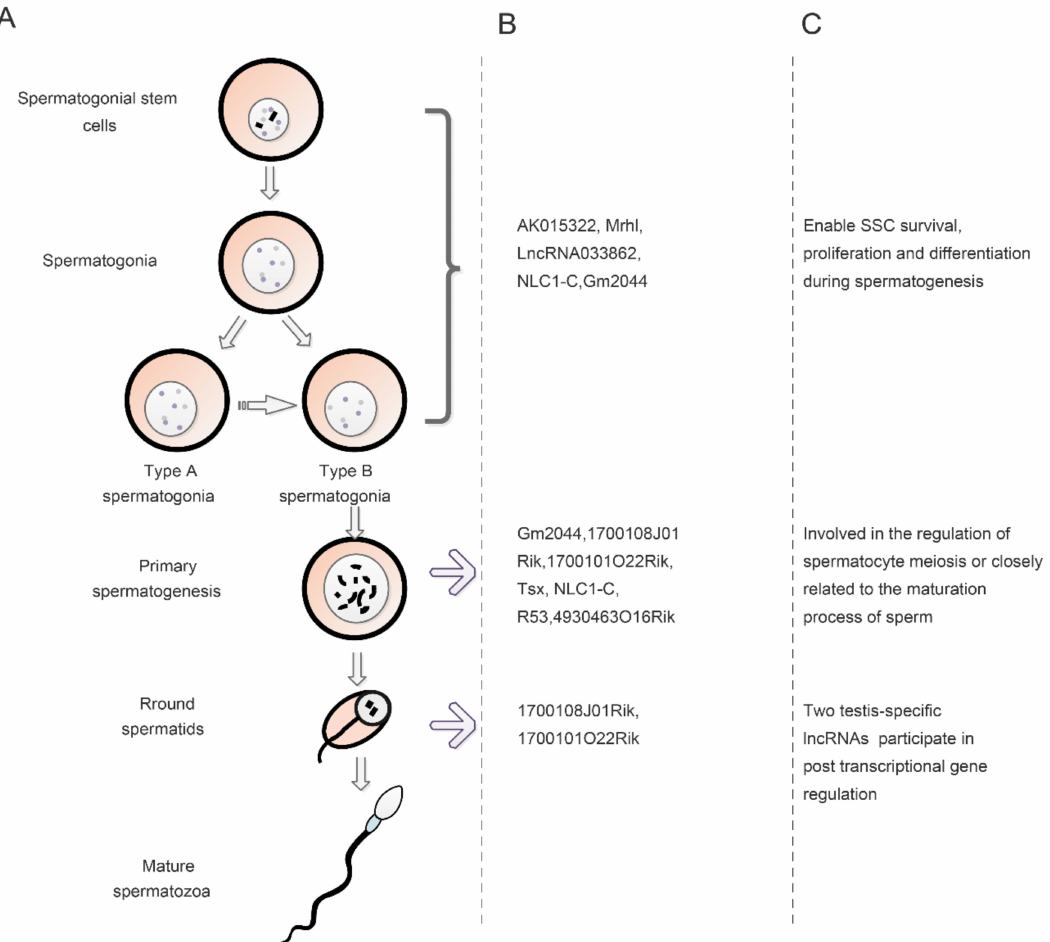
Figure 4. The different stages of spermatogenesis during which a spermatogonium undergoes division, differentiation, and meiosis to produce spermatozoa. ( A ) The process of spermatogenesis. ( B ) The lncRNAs that are involved in the regulation of spermatogenesis. ( C ) The primary function of lncRNAs in the regulation of spermatogenesis. Gonocytes produce spermatogonial stem cells in the postnatal testes; these develop from the primordial germ cells. Spermatogonial stem cells then undergo mitosis to produce type A spermatogonia, thus producing spermatogonial stem cells. These then develop into type B spermatogonia, which differentiate germ cells into diploid primary spermatocytes. During meiosis I, primary spermatocytes divide into secondary spermatocytes. During meiosis II, the secondary spermatocytes produce four haploid spermatids. During spermiogenesis, spermatids differentiate to produce spermatozoa through morphological changes, including flagellum development, nuclear condensation, acrosomal formation, and cytoplasmic